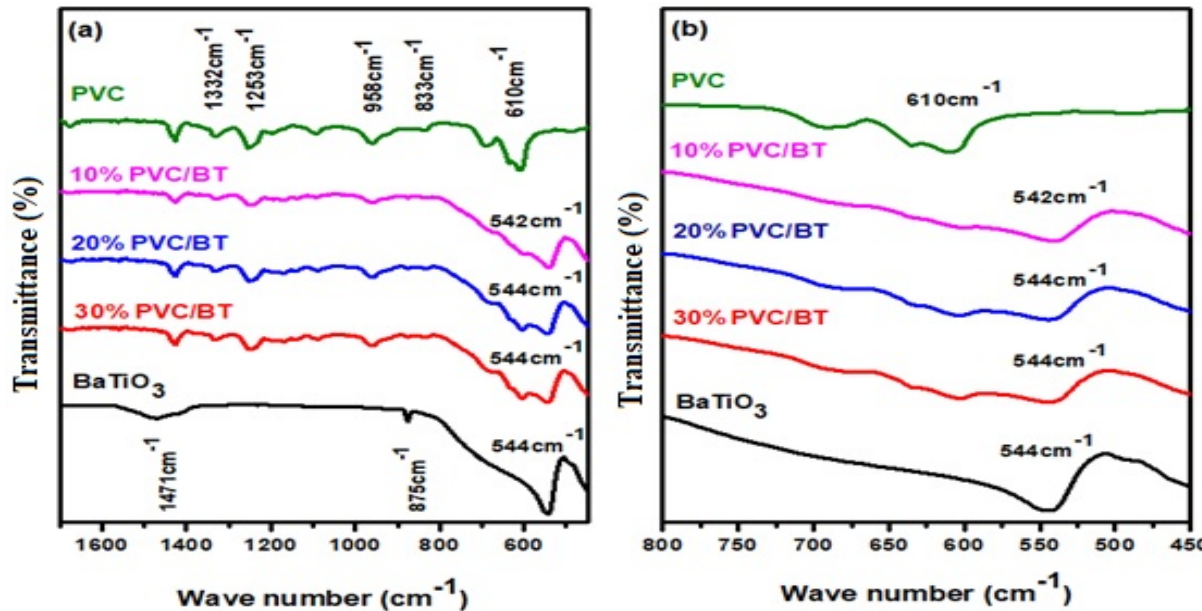
Figure 4. ( a ) FTIR absorption spectra of BT, PVC and PVC/BT composites with various BT content in PVC matrix; ( b ) shows that the relative intensities of peaks are decreased with the decrease in PVC content.